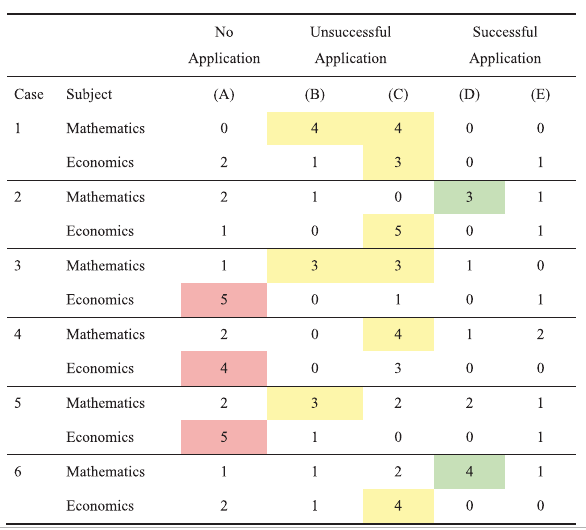
Note. A: no application of knowledge, B: unsuccessful application, C: unsuccessful partial application, D: partially successful application, E: successful application (for code descriptions, see Sample and Data Analysis